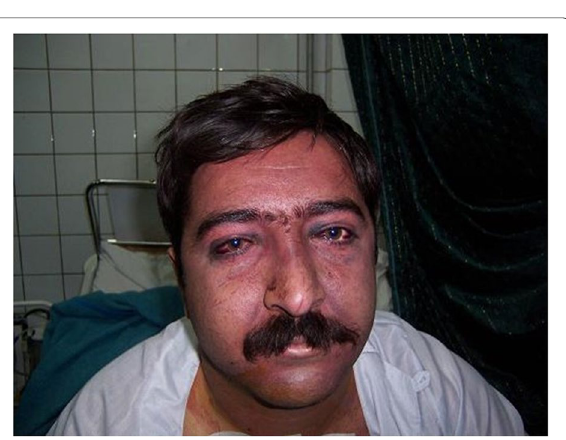
Fig. 6 More resolution of sub-conjunctival hemorrhage and facial discoloration few days after